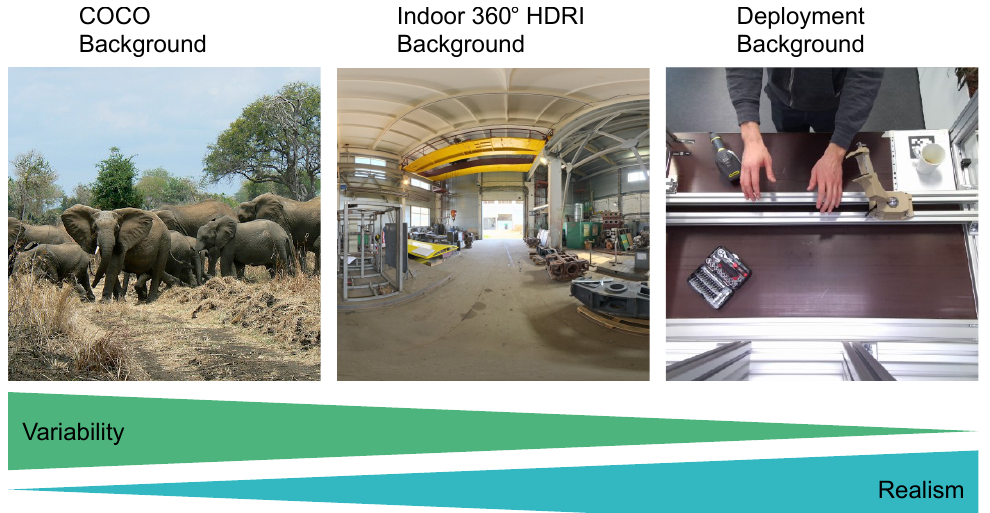
Figure 6. The three different types of background images which were used. With these three choices we investigate the trade-off between image variability and level of